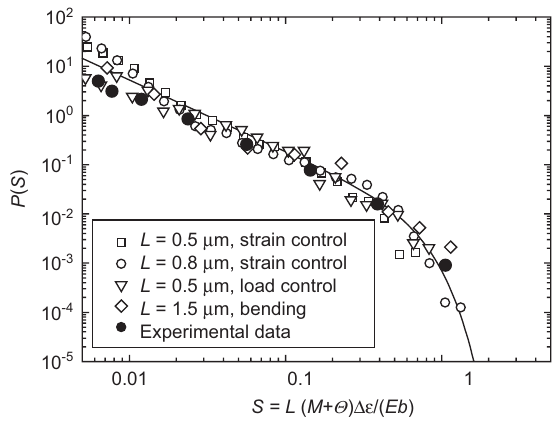
Figure 11 Comparison of the statistics of strain burst sizes in microcompression and microbending simulations and in micropillar compression experiments [25]. Full line, Fit according to Eq.